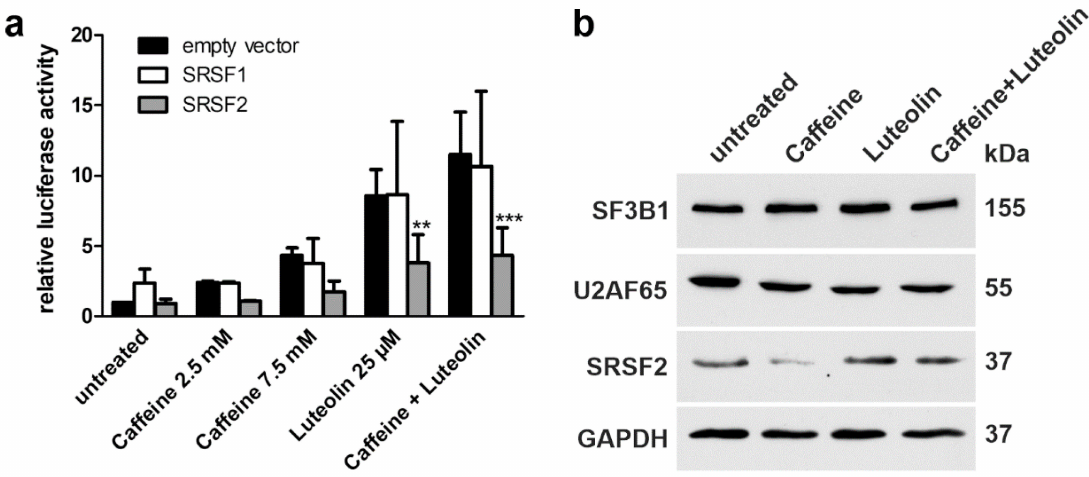
Figure 13. Expression of SRSF upon luteolin and caffeine treatment. ( a ) HEK293T cells were cotransfected with equal amounts of the AGA -luciferase minigene construct and the expression constructs for SRSF1, SRSF2, or empty pEXPR-IBA103. Cells were treated with the indicated amounts of the substances for 24 h. Relative luciferase activity of the untreated samples cotransfected with the empty vector was set as 1. Bars represent the mean ± SD of at least three independent experiments, two-way ANOVA against the samples cotransfected with the empty vector. Values of p < 0.01 were considered very significant (**) and p < 0.001 extremely significant (***). ( b ) Expression level of splice factors in patient fibroblasts. Cells were treated with caffeine (7.5 mM), luteolin (25 µ M) or a combination of 2.5 mM caffeine and 25 µ M luteolin for 48 h. Cell lysates were used for Western blotting. GAPDH served as a loading control. Results are representative for three independent